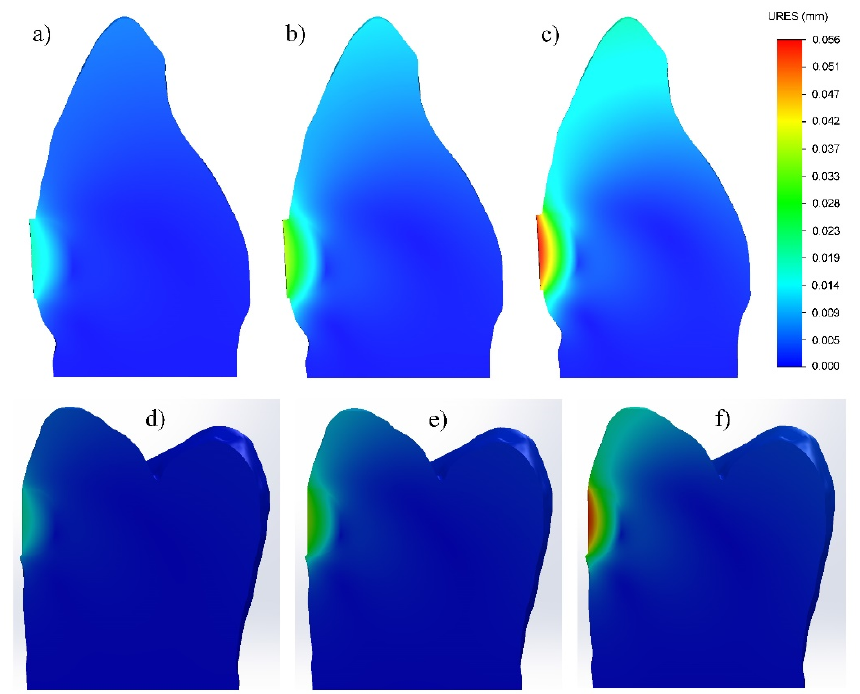
Figure 4. Displacement during setting process of fillings made with: ( a ), ( b ), ( c ) glass-ionomer cement; ( d ), ( e ), ( f ) flowable photo-cured composite. (1% shrinkage—( a ), ( d ); 2% shrinkage—( b ), ( e ); 3% shrinkage—( c ), ( f )).